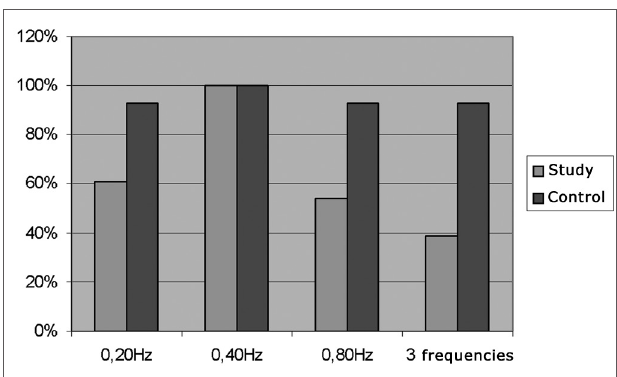
Figure 1. Pendular tracking - Percentage of children who were able to perform the pendular tracking test in the frequencies of 0.20Hz; 0.40Hz; 0.80Hz in the three frequencies. Relationship between the